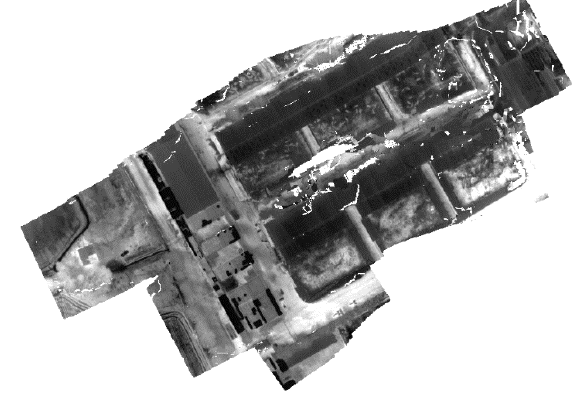
Figure 7. Thermal orhto-photo